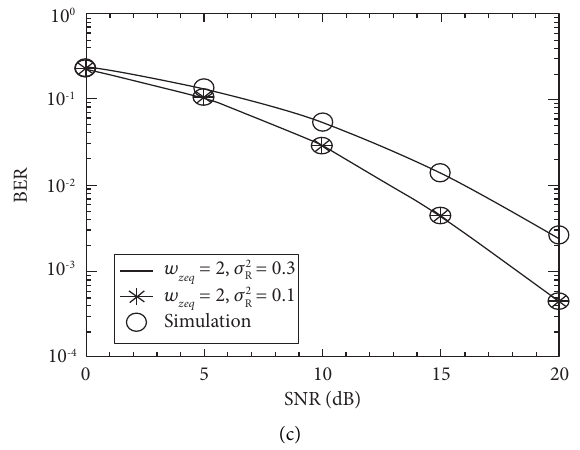
Figure 2: The calculation process between different variables of the RSM turbulence